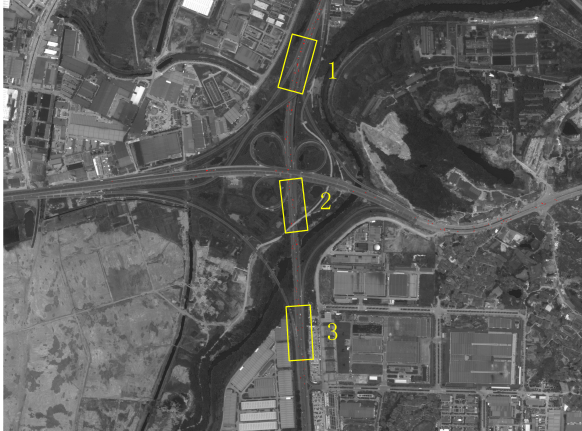
Figure 14: Result of the proposed algorithm. Three regions are marked with yellow rectangles. Local results of three regions is illustration in Figure 16-18